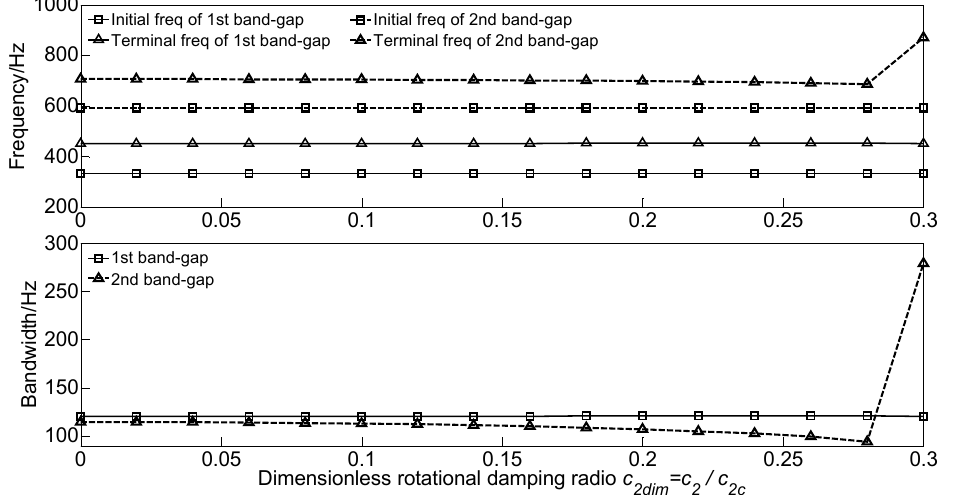
Figure 10. Band gaps maps as functions of dimensionless rotational damping radio c 2dim.